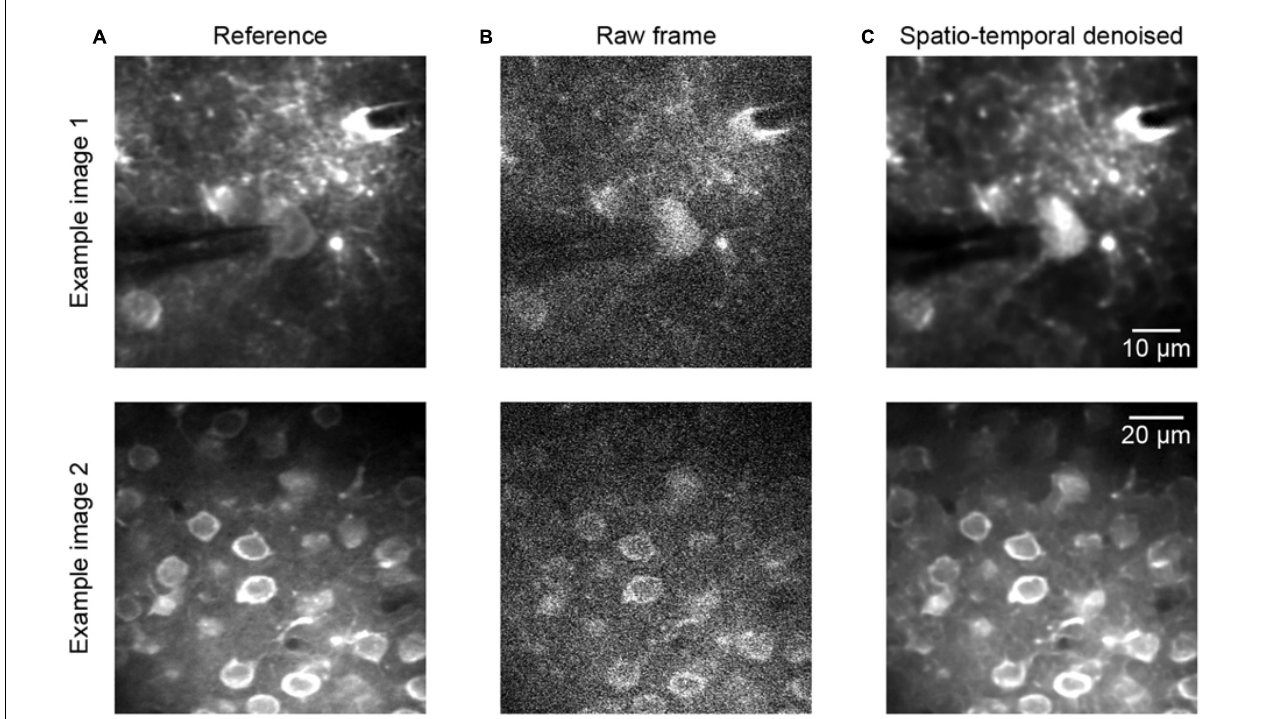
FIGURE 4 | Denoising performance of two representative raw two-photon imaging frames. (A) The ground truth references. (B) Raw single frames of two-photon imaging data (the middle FOV of the three FOV stack): example 1 PSNR 20.54/SSIM 0.14 and example 2 PSNR 17.85/SSIM 0.11. (C) Restored images after application of the model blind spatiotemporal filtering method: example 1 PSNR 32.35/SSIM 0.95 and example 2 PSNR 24.70/SSIM 0.87.